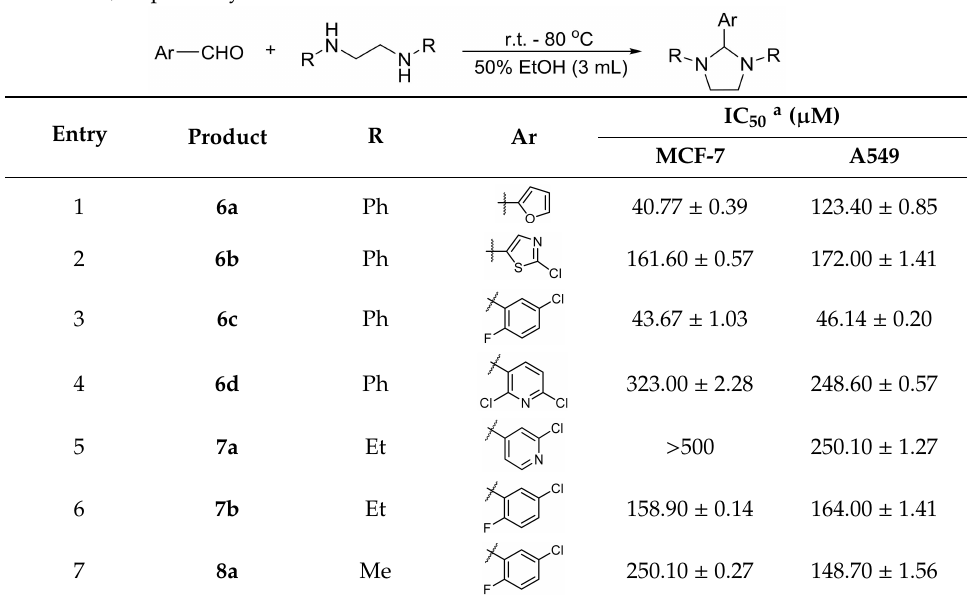
Table 2. E ff ect of substituents of nitrogen atoms on the anti-proliferative activity against MCF-7 cells and A549 cells, respectively.